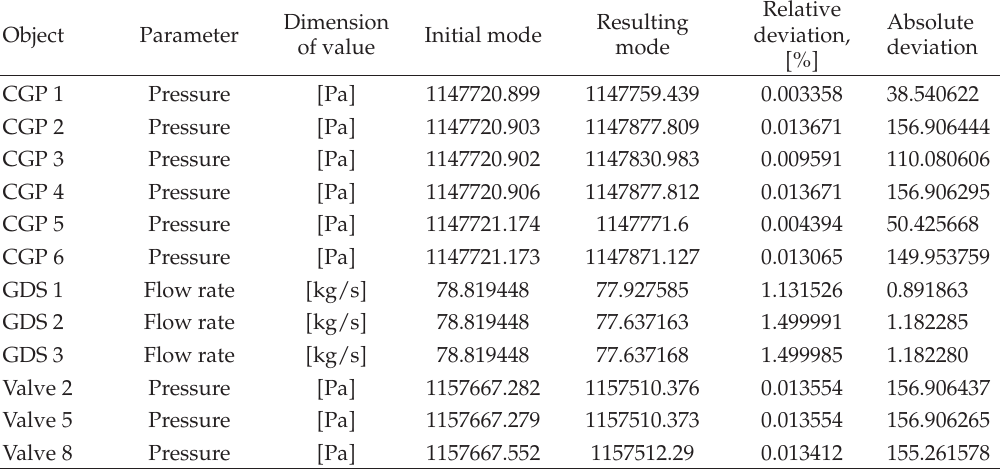
Table 12: Final deviations between numerical estimates of gas flow parameters and the results of their